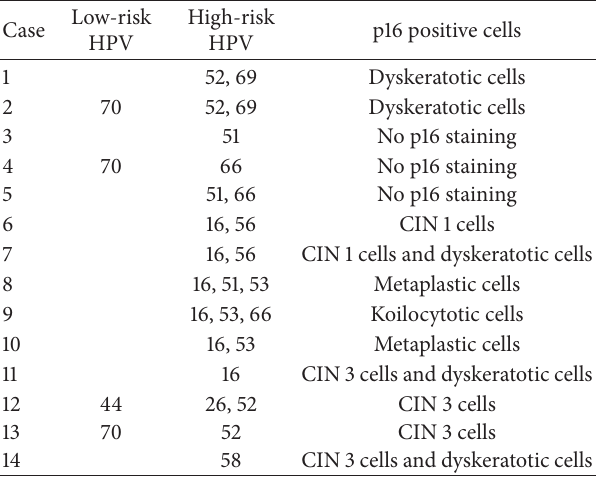
Table 2: Cytology of the ThinPrep slide and cytohistology of the Cellient paraffin